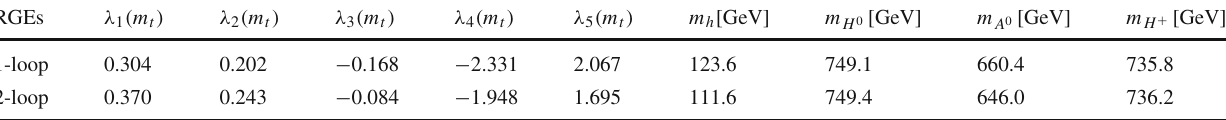
Table 1 The running quartics at the one- and two-loop level for the input given in (17). The given values for the masses correspond to a two-loop calculation using tan β = 1 . 4 and M 12 = − 500 2 GeV